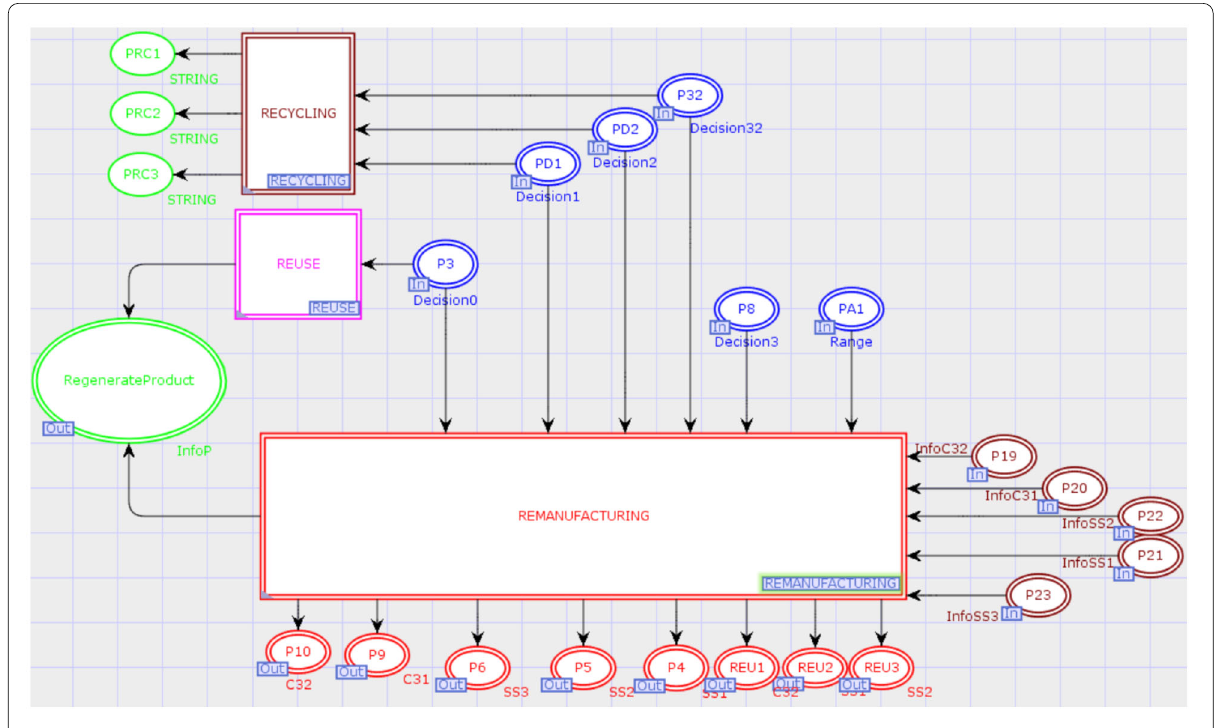
Figure 7 A regeneration processes GCSPN